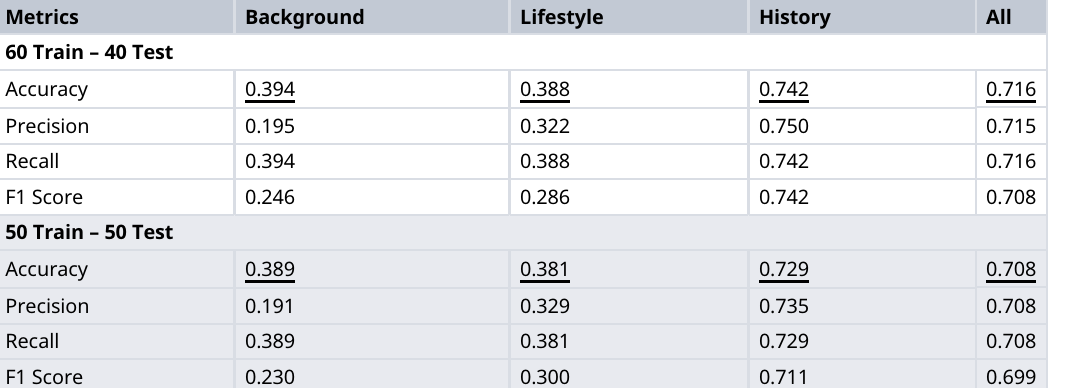
Table 7. SVM (5 Levels).